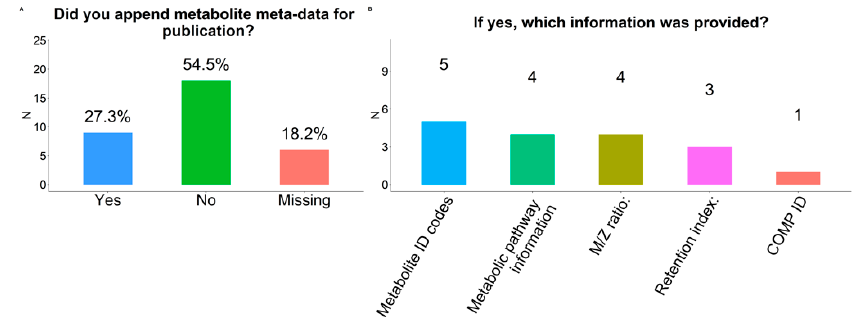
Figure 6. Appending metabolite meta-data in publications of findings from participating COMETS cohorts. ( a ) Include meta-data for publication (yes/no); ( b ) Information provided in appended meta- data.